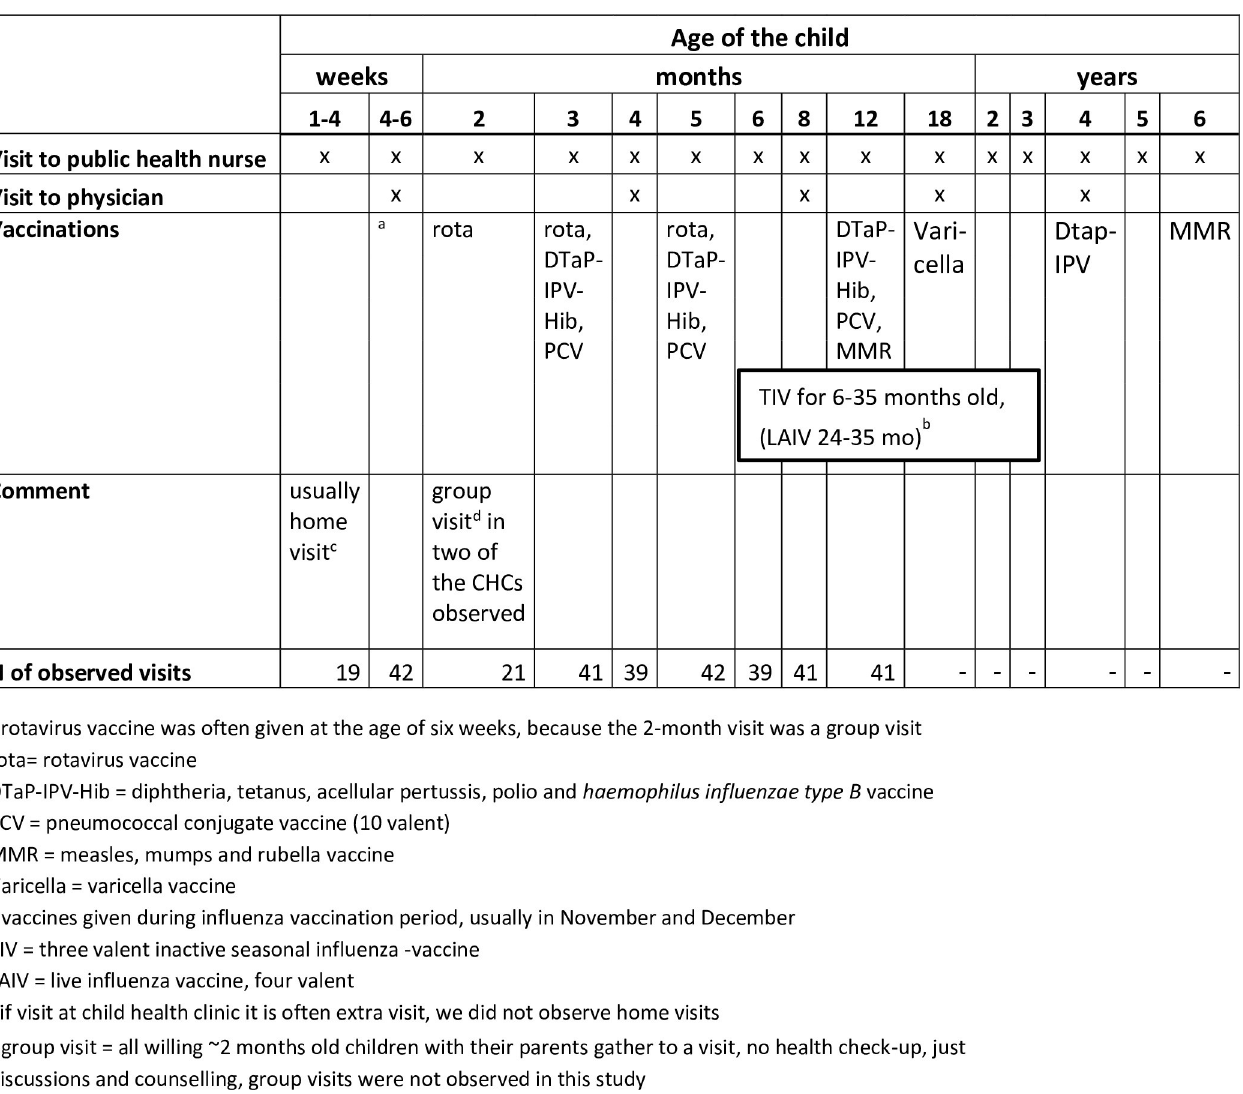
Fig 1. Child-health-clinic visits and vaccination schedule of national vaccination program in autumn 2017.